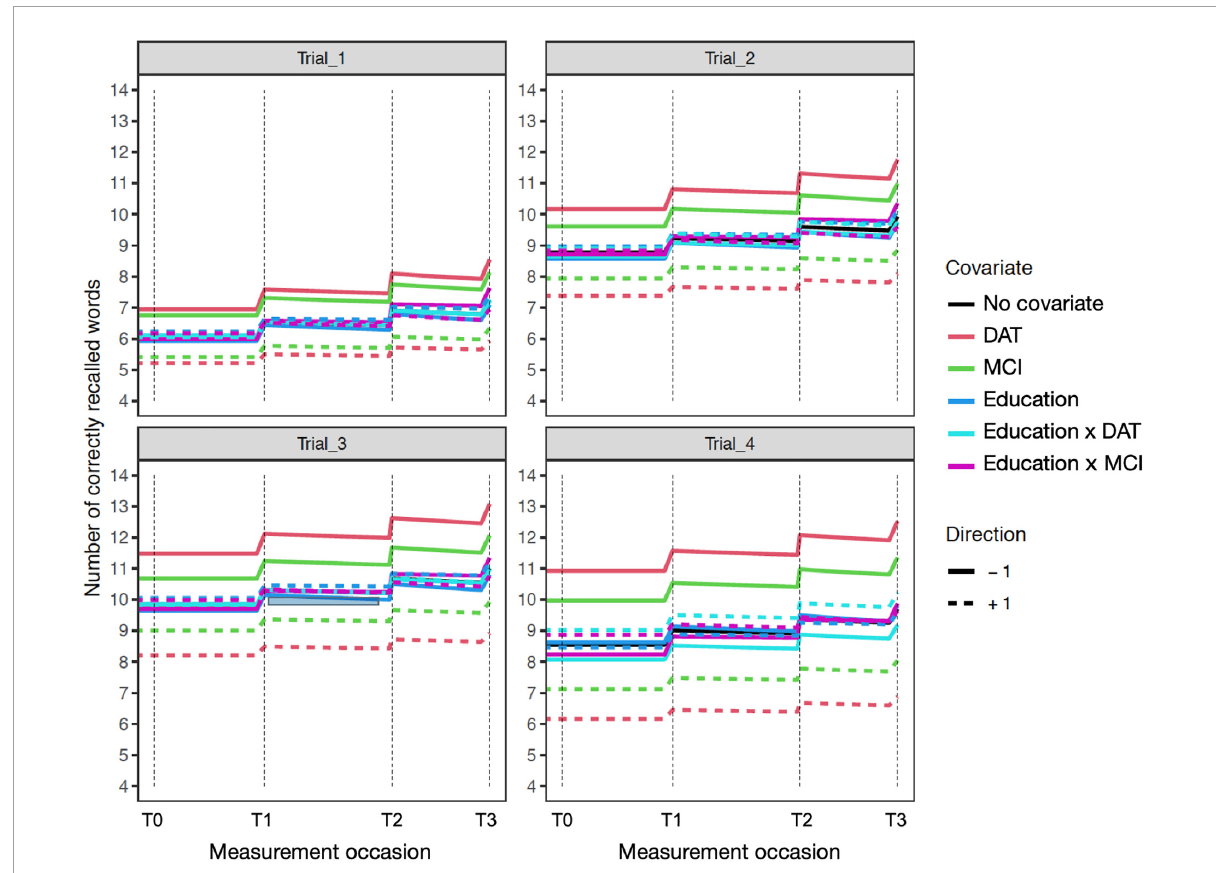
FIGURE2 Education sensitivity model expectation plots for change in recall performance (black line) across four measurement occasions (e.g., T0: baseline, T1: 1 year). The solid and dashed colored lines depict effect modification by time independent predictors: DAT diagnosis (red lines), MCI diagnosis (green lines), Education (blue lines; higher: +1; lower: –1), and interactions of Education × DAT and Education × MCI. For covariate effects, higher (dashed) and lower (solid) levels of the covariate are shown to modify the level and expected slope. All covariate effects are in reference to 0 values of other covariates. The dashed red line reflects DAT, and the solid red line represents all other participants. Interaction effects only represent the total additive value of the interaction holding the main effects at zero. For example, in Trial_4 (lower right), the interaction of educational attainment and DAT shows higher education (+1) is associated with better performance in those with dementia